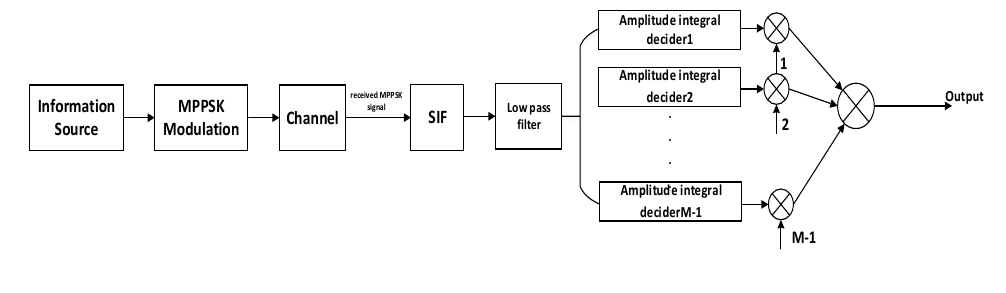
Figure 3. MPPSK system structure.